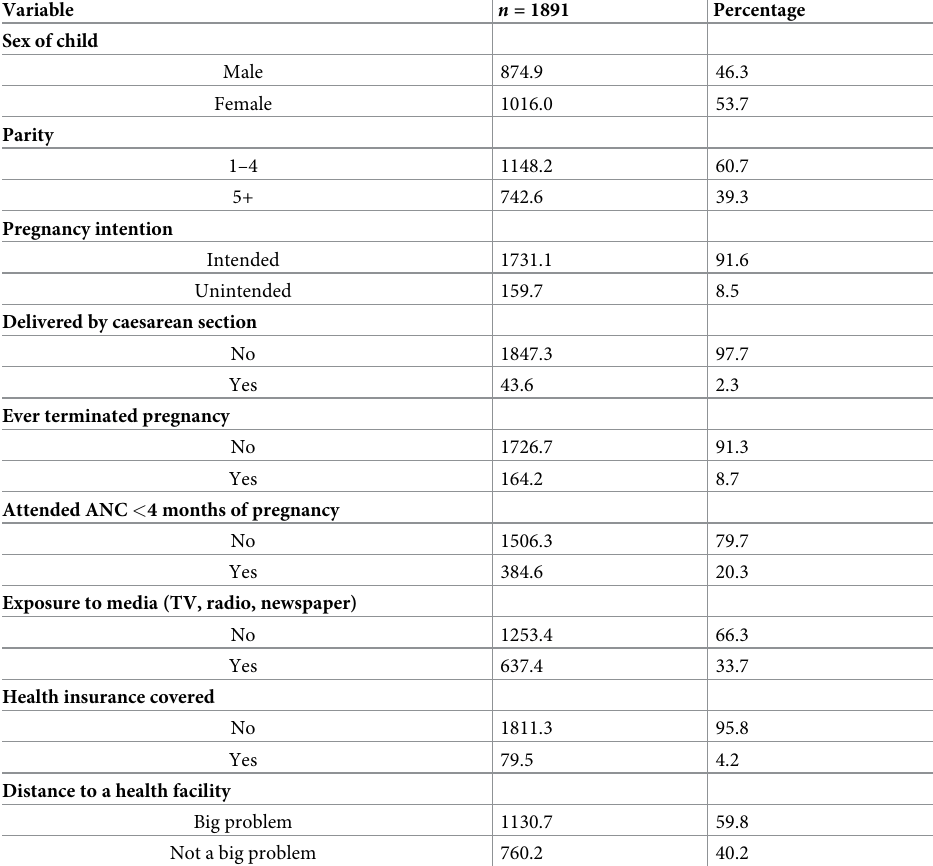
Table 2. Reproductive characteristics of the study population, Ethiopian Demographic Health Survey, 2016.